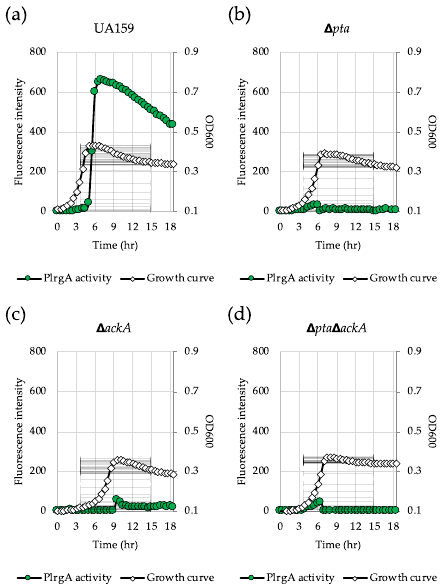
Figure 6. The contribution of the Pta-AckA pathway to stationary phase P lrgA activity. For measurement of P lrgA activation, the P lrgA-gfp reporter strain in the wild type UA159 ( a ), ∆ pta ( b ), ∆ ackA ( c ) and ∆ pta ∆ ackA ( d ) backgrounds, was grown in FMC11 medium. Relative gfp expression (green circle) and cell growth (white diamond) was monitored during growth on a plate reader (see Materials and Methods for details). The results are representative of three independent experiments.